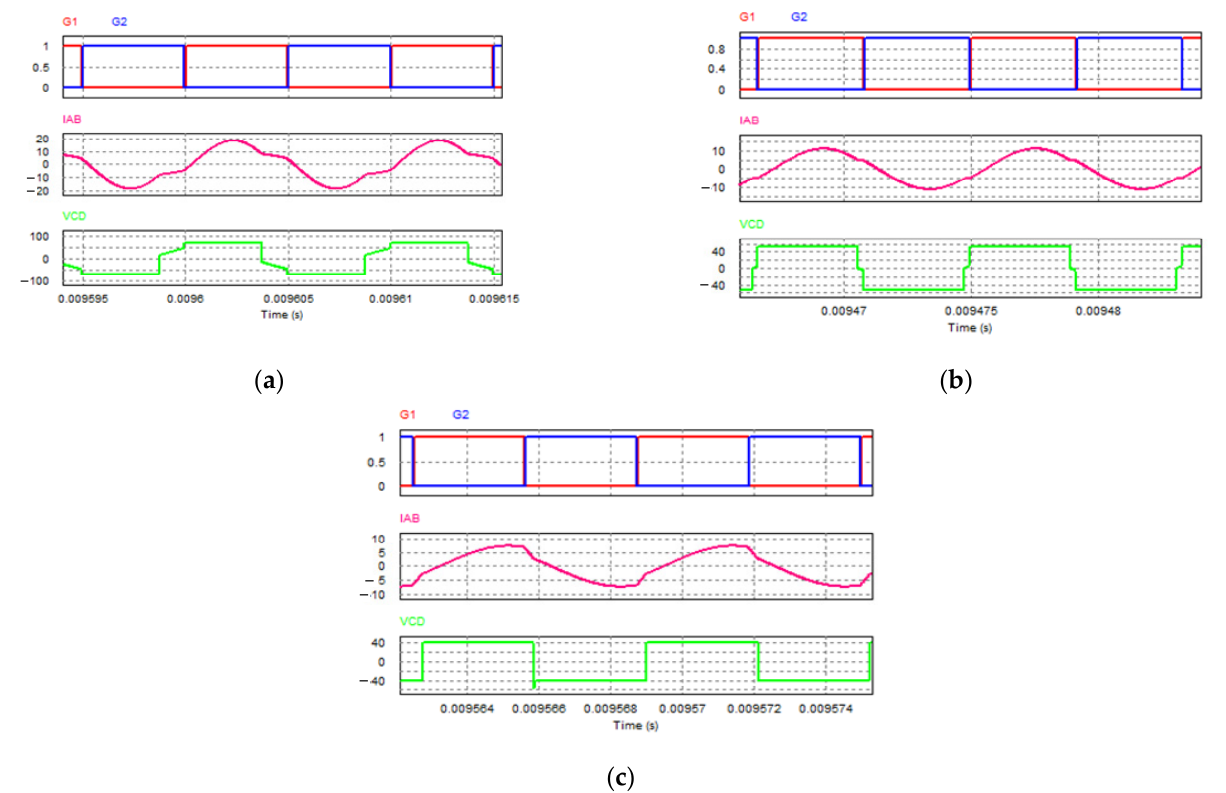
Figure 6. Simulation waveforms in step-down mode, 400 V, 1 Ω : ( a ) 90 kHz; ( b ) 120 kHz; ( c ) 160 kHz.